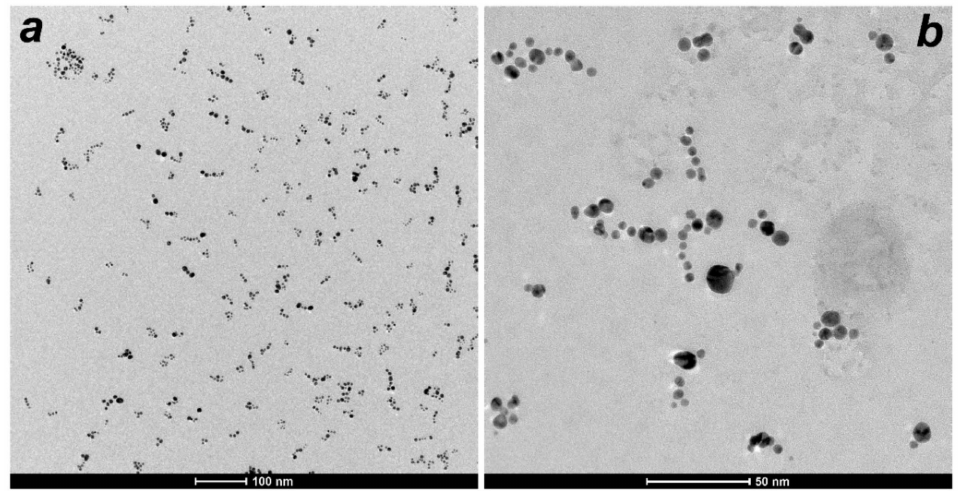
Figure 2. TEM images of D-g-PNIPAM/AuNPs nanohybrids at the temperature of 20 ◦ C acquired at lower ( a ) and higher ( b )